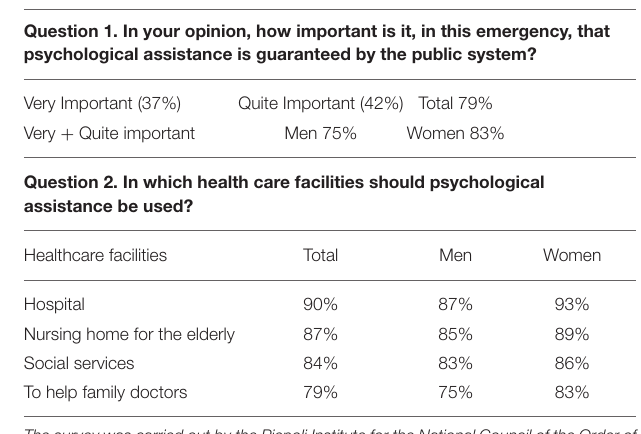
TABLE 4 | Italian opinion on psychological assistance during the